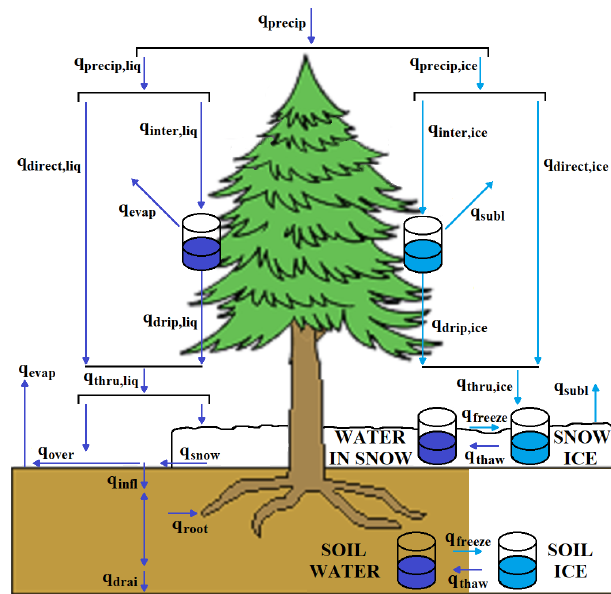
Figure 2. The hydrological system in the new version of MAID- ENiso. Pools (flasks) and fluxes (arrows) are shown for liquid water in dark blue and for snow/ice in light